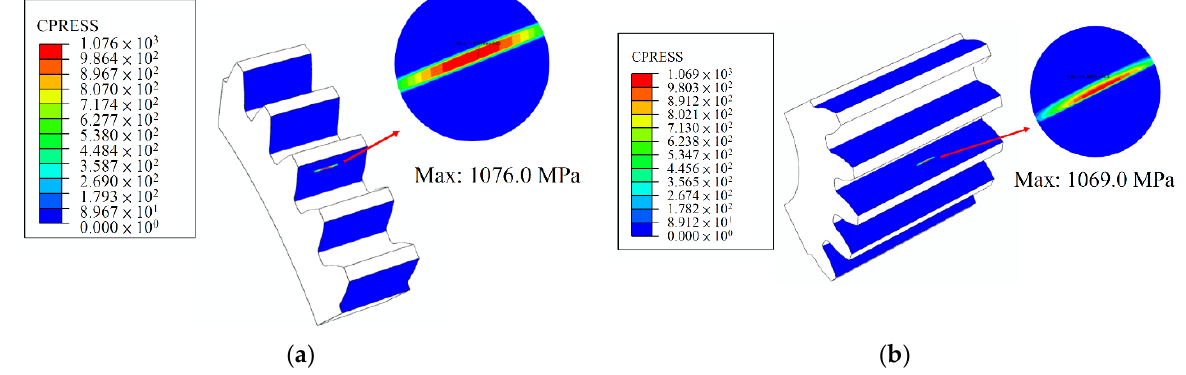
Figure 7. FEA of optimum design under ideal assembly state: ( a ) gear; ( b ) pinion.